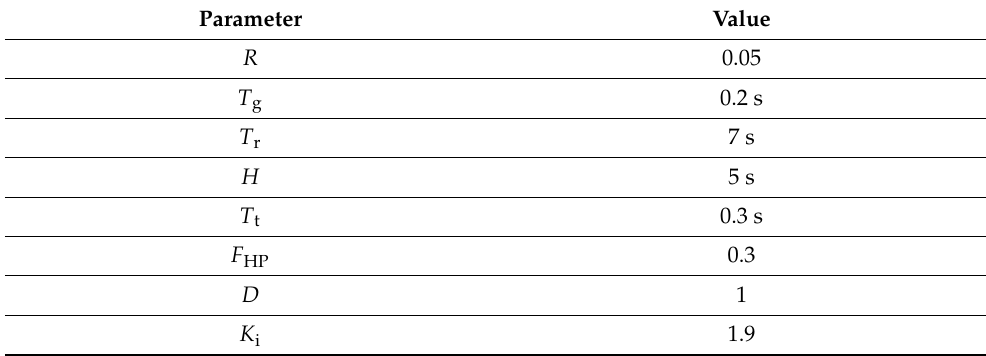
Table 2. Parameters for the frequency response model.